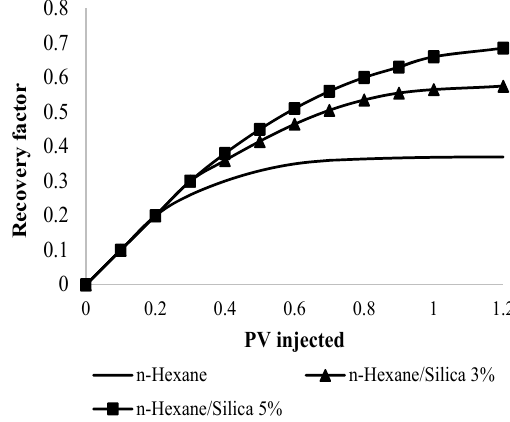
Fig. 8. Oil recovery factor for water base nanofluids